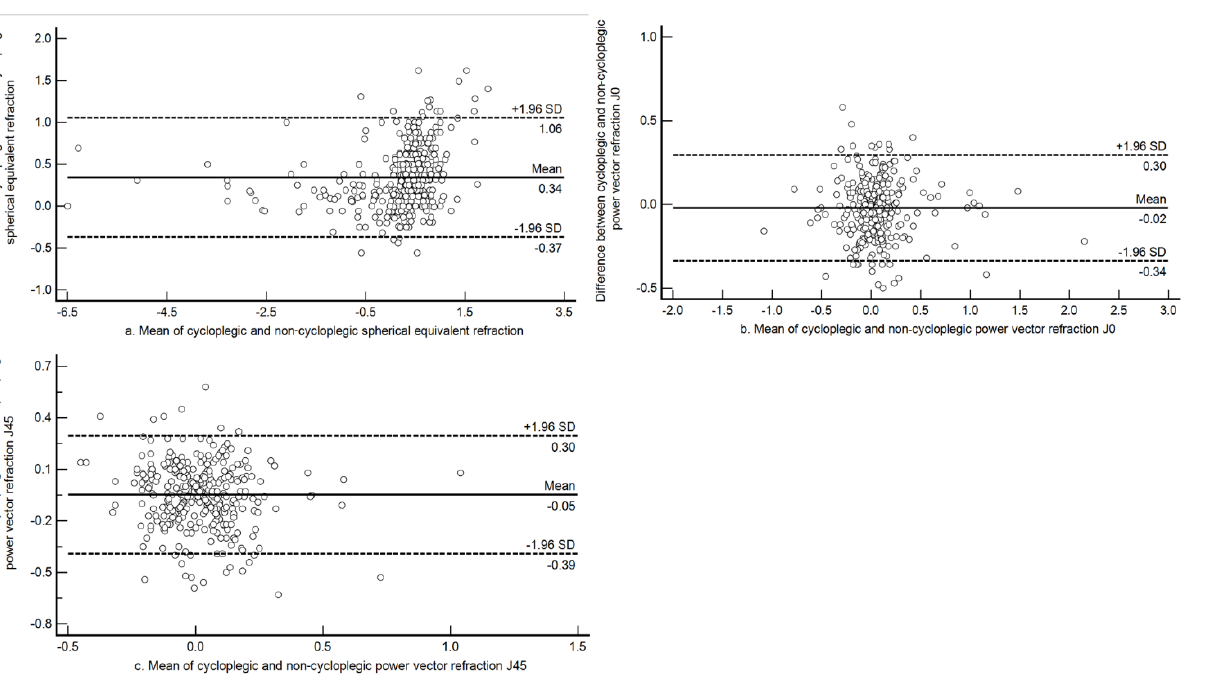
Figure 1. Bland-Altman plot assessing agreement between cycloplegic and non-cycloplegic refraction estimates for spherical equivalent refraction, J0 and J45 among all the children in the sample. ( a ) Agreement between cycloplegic and non-cycloplegic refraction for M; ( b ) agreement between cycloplegic and non-cycloplegic refraction for J0; ( c ) agreement between cycloplegic and non-cycloplegic refraction for J45. The central solid line represents the mean difference between the two measurements, and the broken lines above and below represents the 95% limits of agreement.